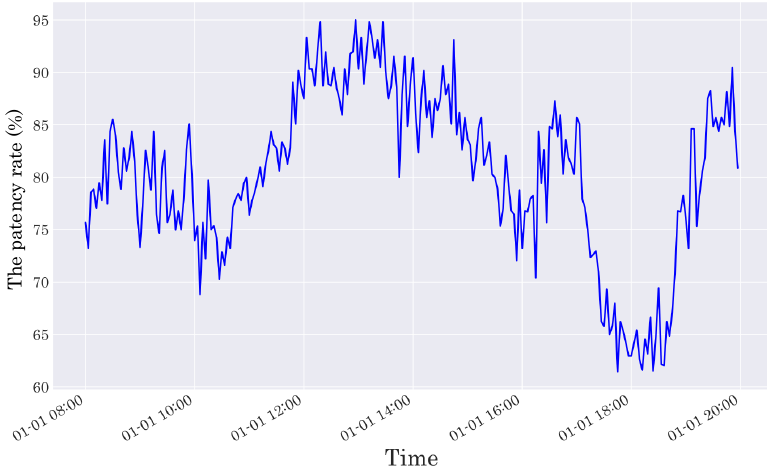
Figure 6. The patency rate in Suzhou street at 8:00 − 20:00, 1 January